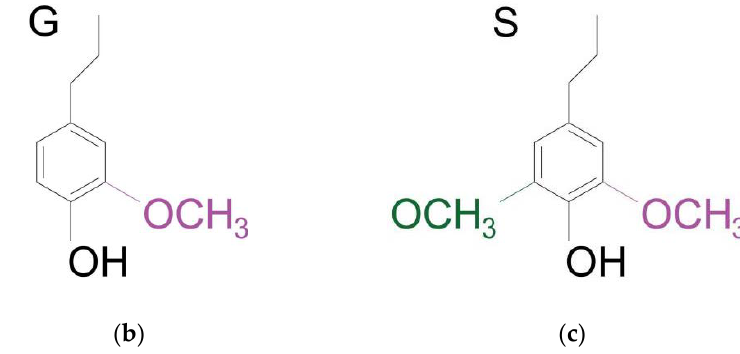
Figure 2. Three types of C 6 C 3 monomer units in lignin [25]. ( a ) p-Hydroxyphenyl unit(H); ( b ) Guaiacyl unit (G); ( c ) Syringyl unit (S).